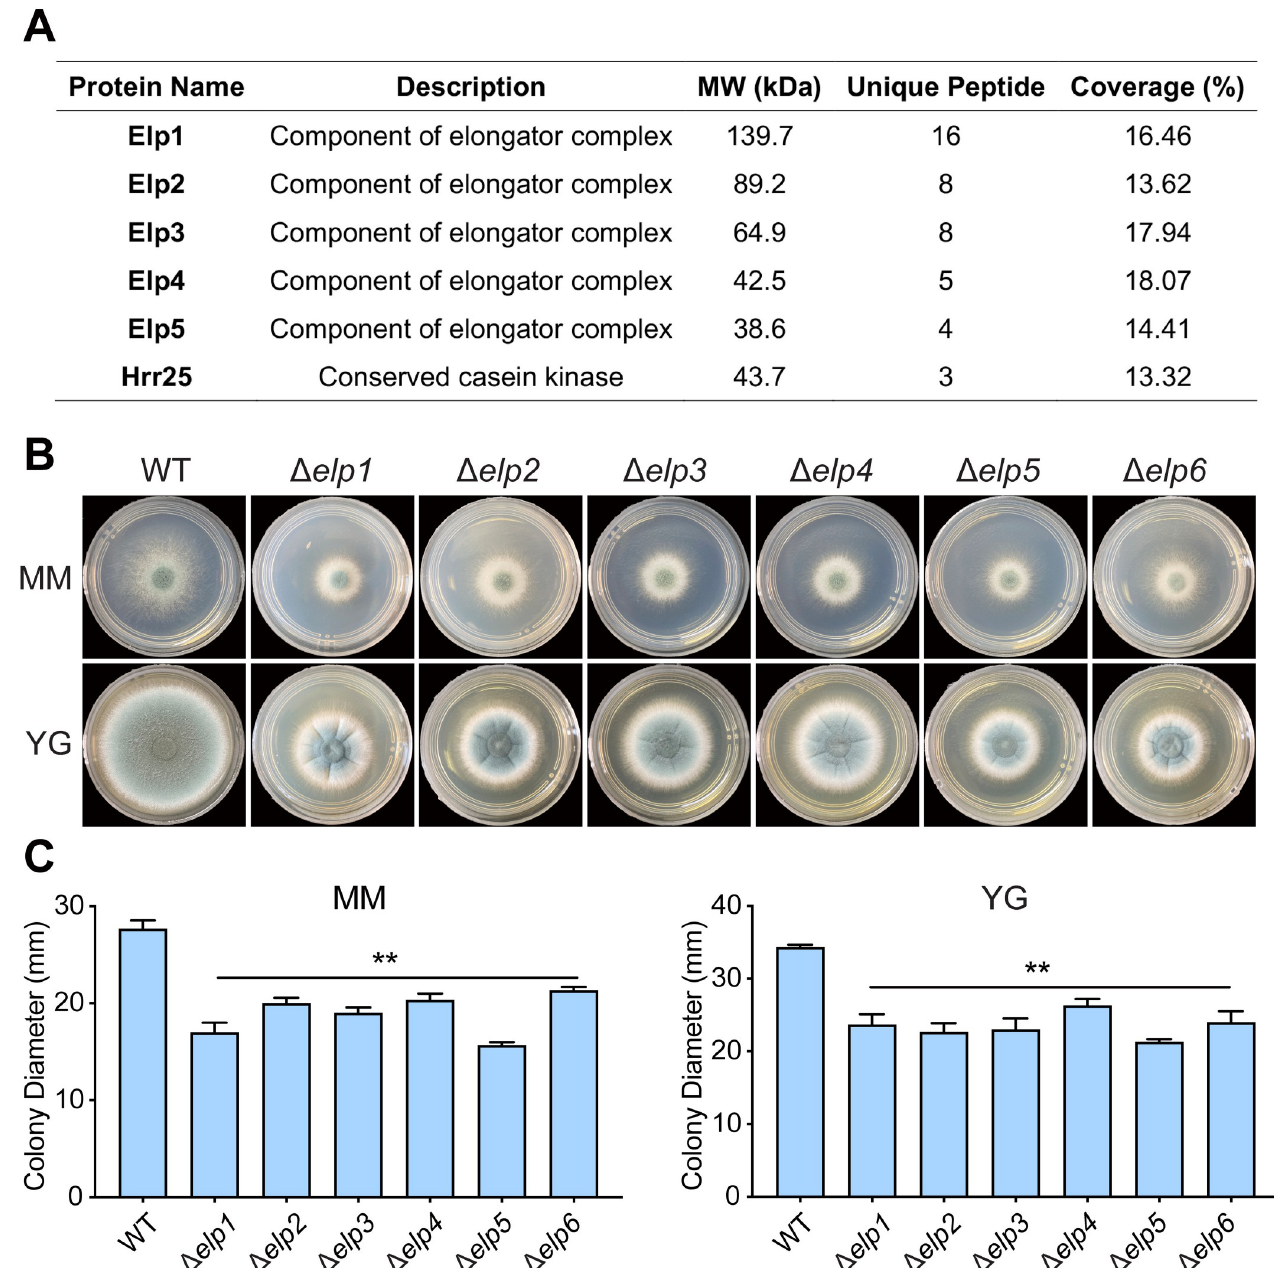
Fig 2. Disruption of each subunit of the Elongator complex leads to similar phenotypic defects. (A) Selected putative Elp3-interacting proteins identified by the FLAG pull-down assay. (B) Growth phenotypes of six Elongator complex subunit-null mutants on solid minimal medium (MM) and complete YG medium at 37˚C for 48 h. (C) Quantitative examination of the diameters of the colonies formed by the indicated strains. The data are presented as the mean ± SEM (standard error of the mean) of three independent experiments. Statistical analysis was performed using one-way ANOVA with multiple comparisons tests. �� p < 0.01; ns, not